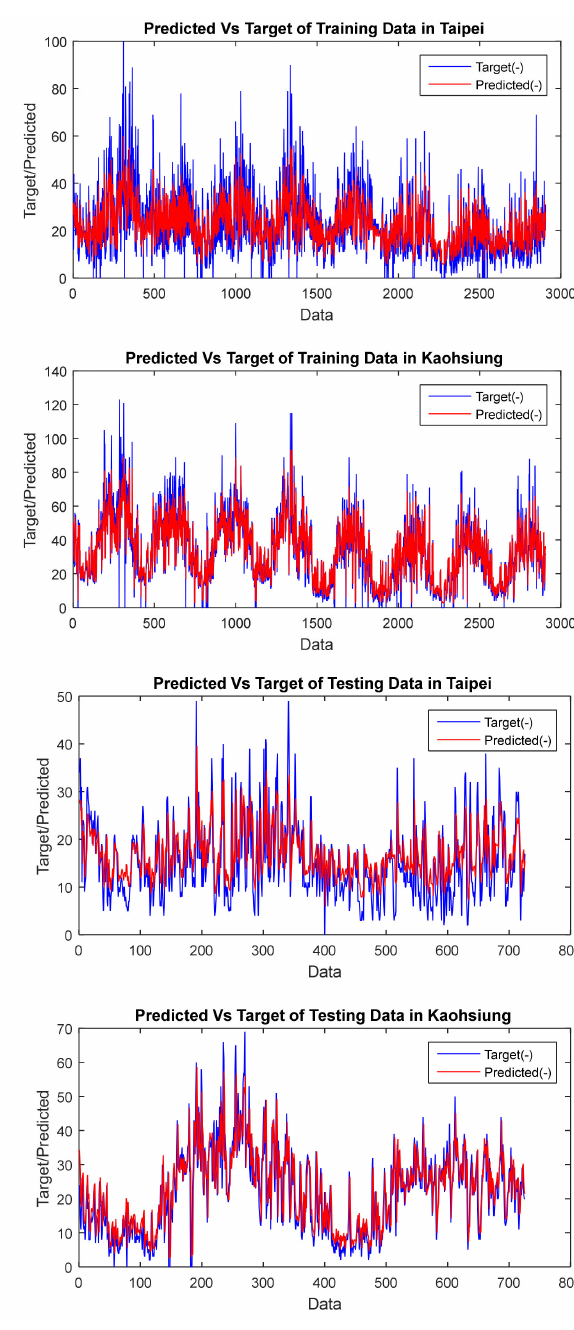
Figure 3. PM 10 GSTAR(1) CFNN